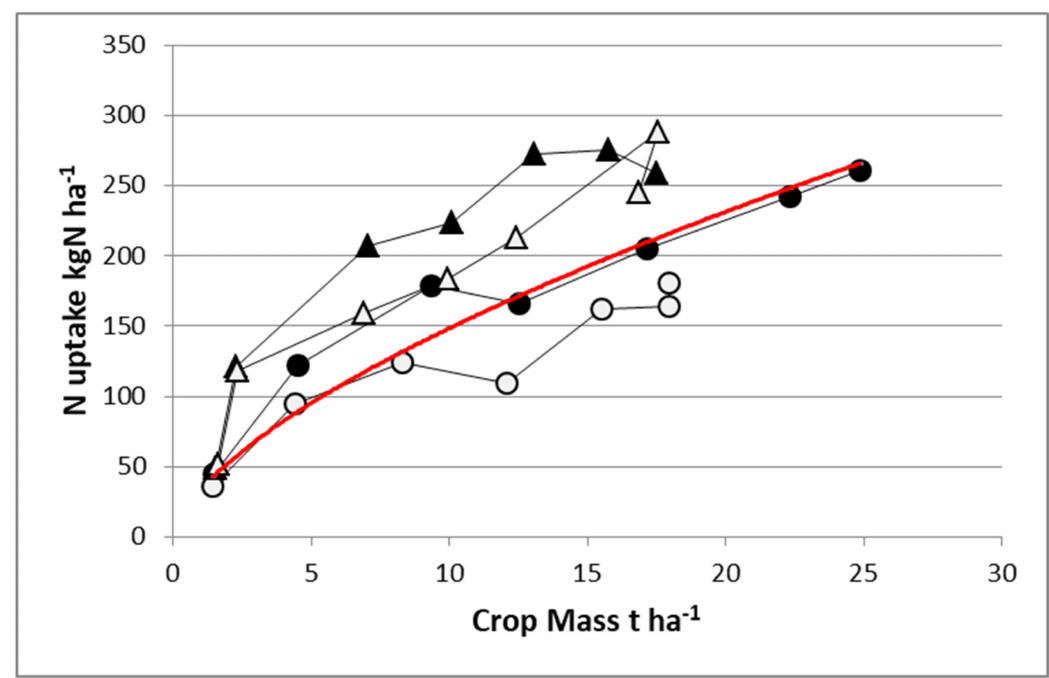
Figure 5. Crop N uptake and aboveground biomass (W) for maize (circles) and sorghum (triangles) growingwithanNfertilizerapplicationrateof200(dark)or30(open)kgN · ha − 1 . Theredlinedenotesthe “critical N uptake curve” common for both crops: N = 34 W 0.64 . Redrawn from Lemaire et al. 1996